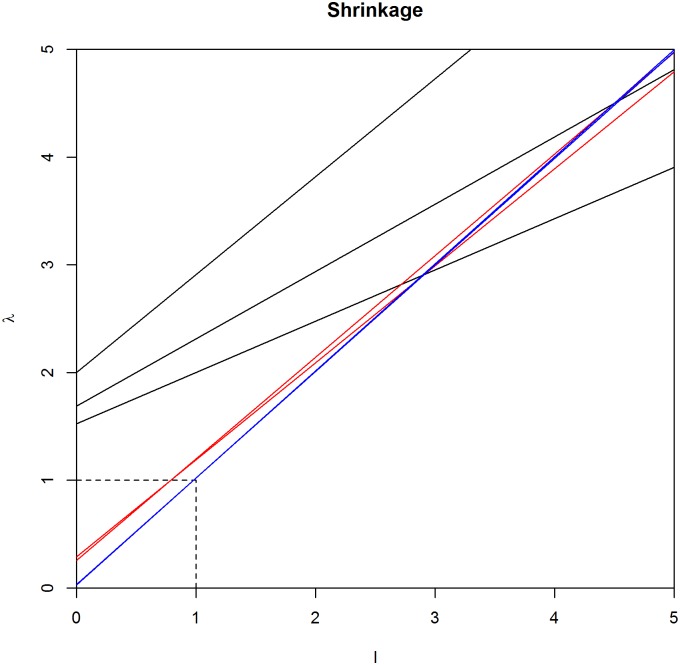
Linear shrinkage of the eigenvalues.Shrinkage of the eigenvalues of the MAP of the covariance matrix as r = α. When n < p, all eigenvalues increase when r is small but when r increases, the increment gets more moderate (black lines). When n increases, shrunken eigenvalues get closer to the sample eigenvalues and the growth of r does not significantly affect the estimated eigenvalues (red lines). When n ≫ p, estimated eigenvalues start to coincide to the sample eigenvalues (blue lines).